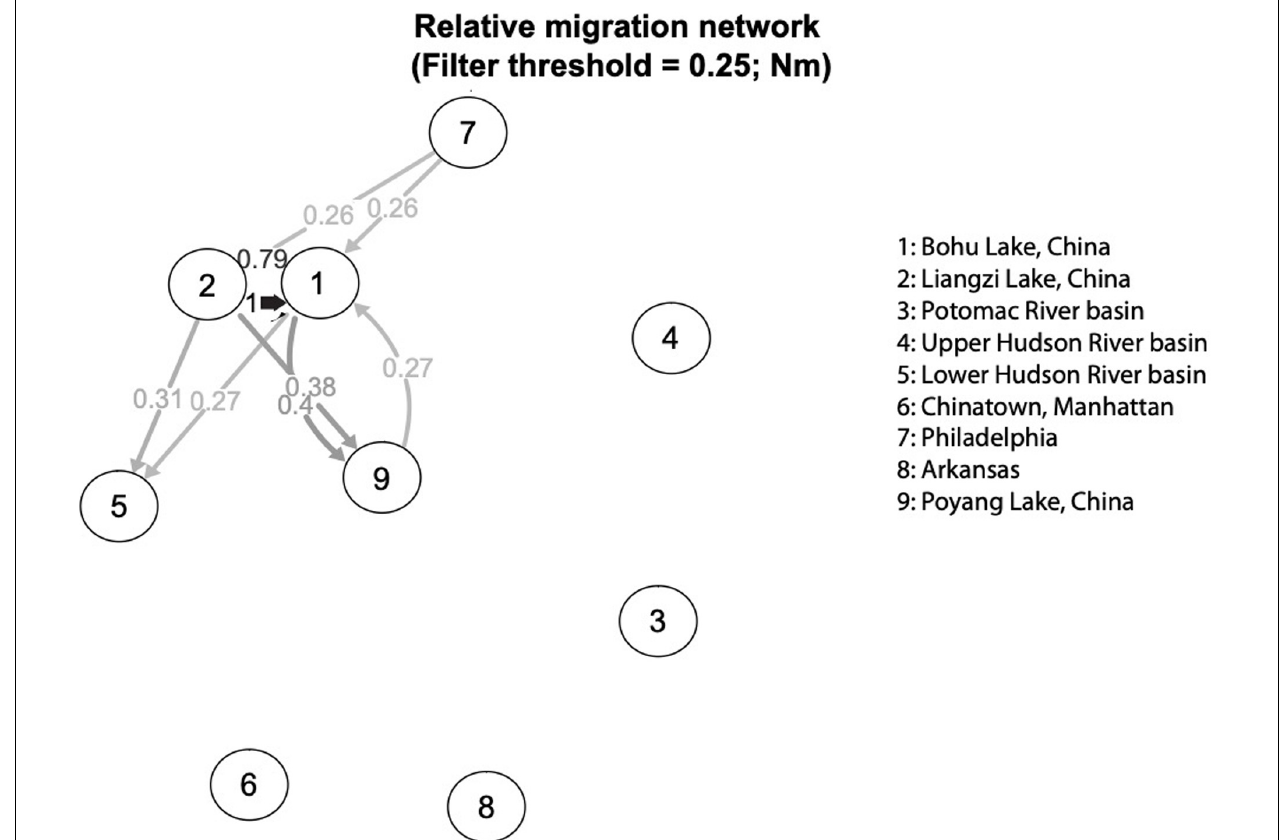
FIGURE 6 | Relative migration network of C. argus putative populations, assessing each Chinese sampling locality separately.